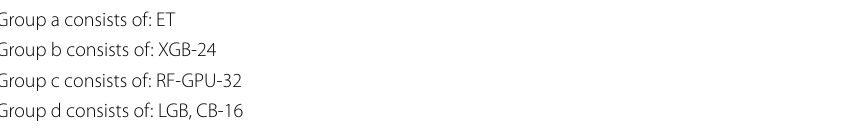
Table 33 HSD test groupings after ANOVA of AUC for the CLF